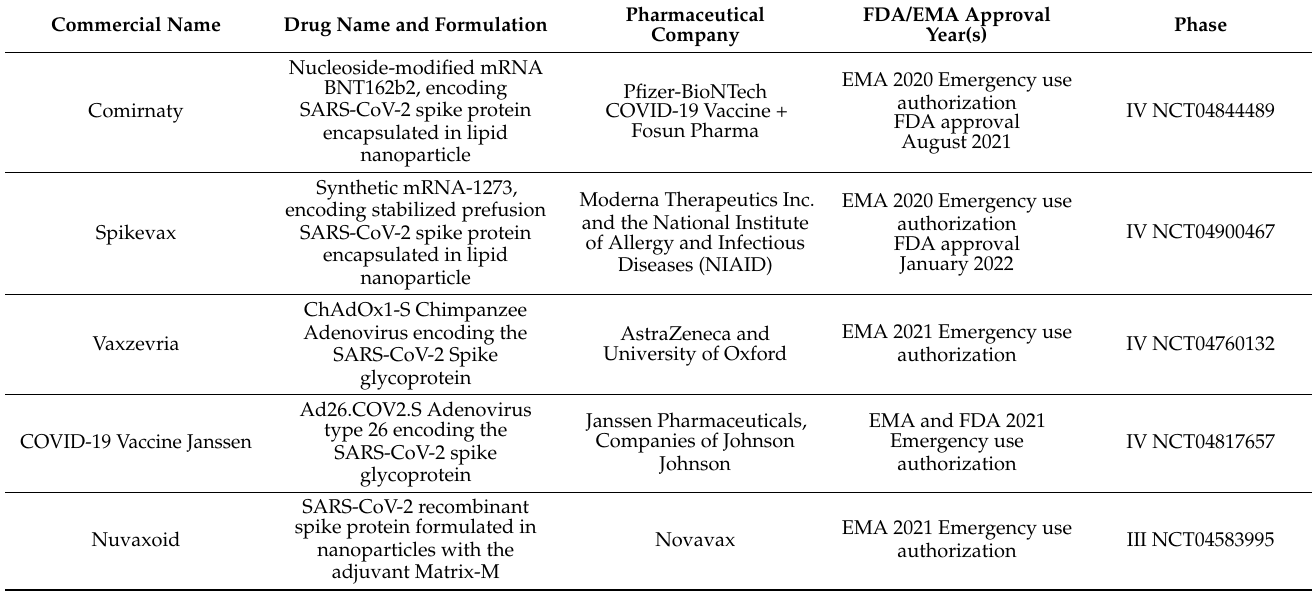
Table 3. Currently (updated to April 2022) FDA/EMA approved nano-based viral vaccinations against SARS-CoV-2